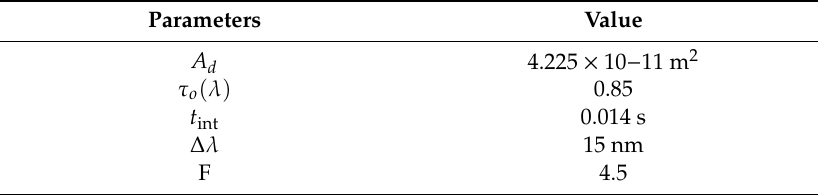
Table 3. Relative parameter values for Equation